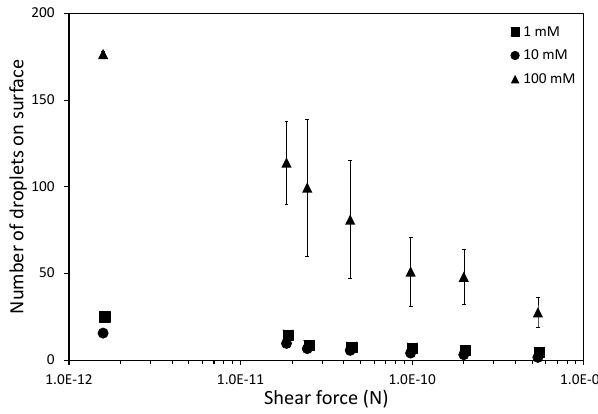
Figure 6. Fraction of droplets that sticks to a cellulose surface for different NaCl concentrations and 463 mg/L SDS. Error bars represent standard deviation after duplicates.